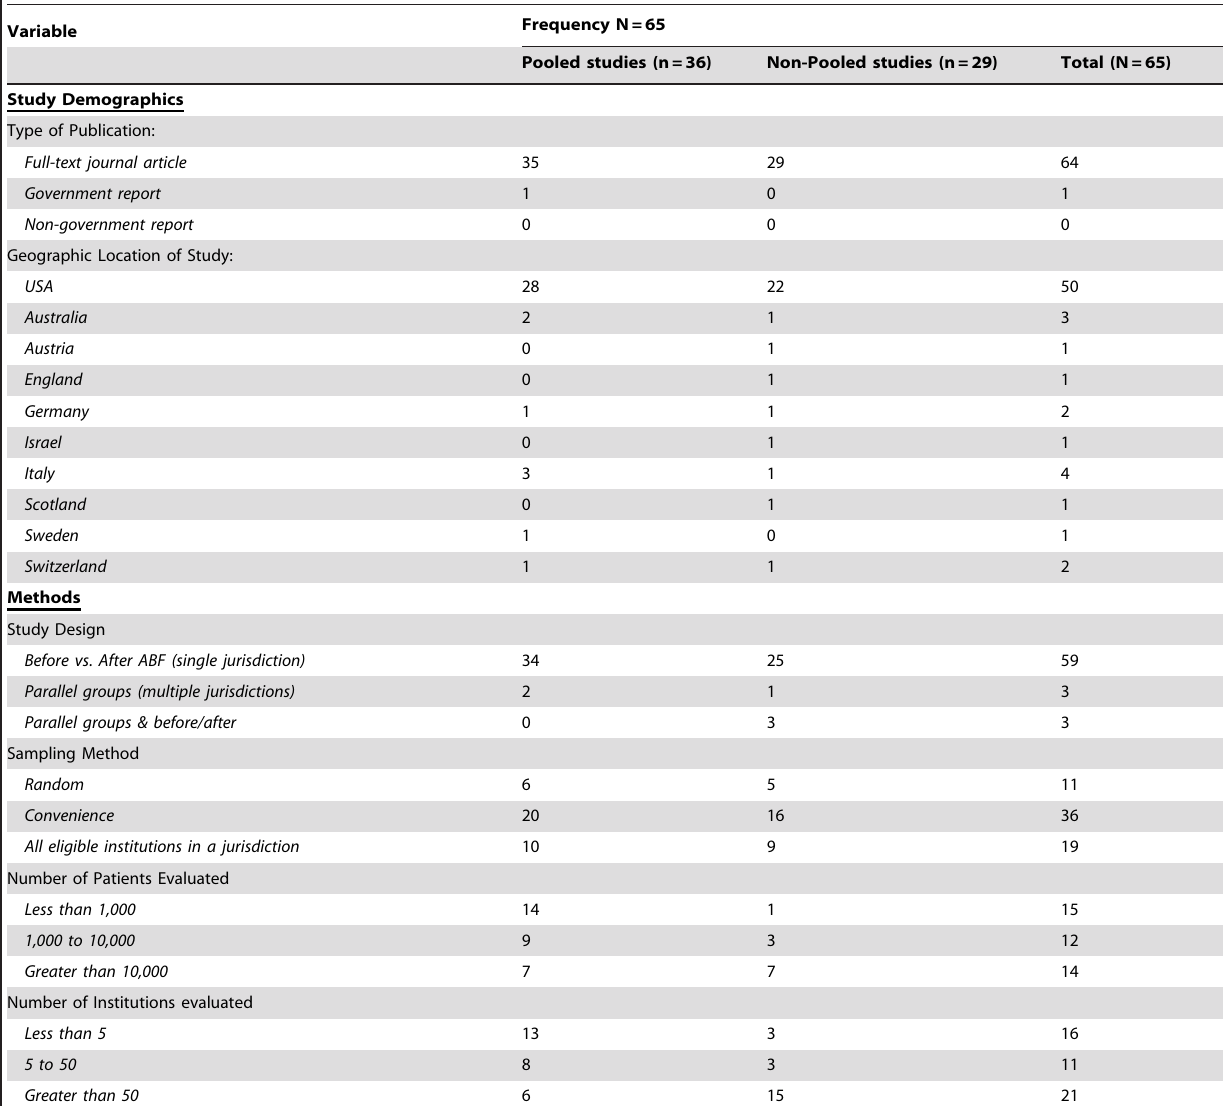
Table 1. Study Characteristics (Pooled and